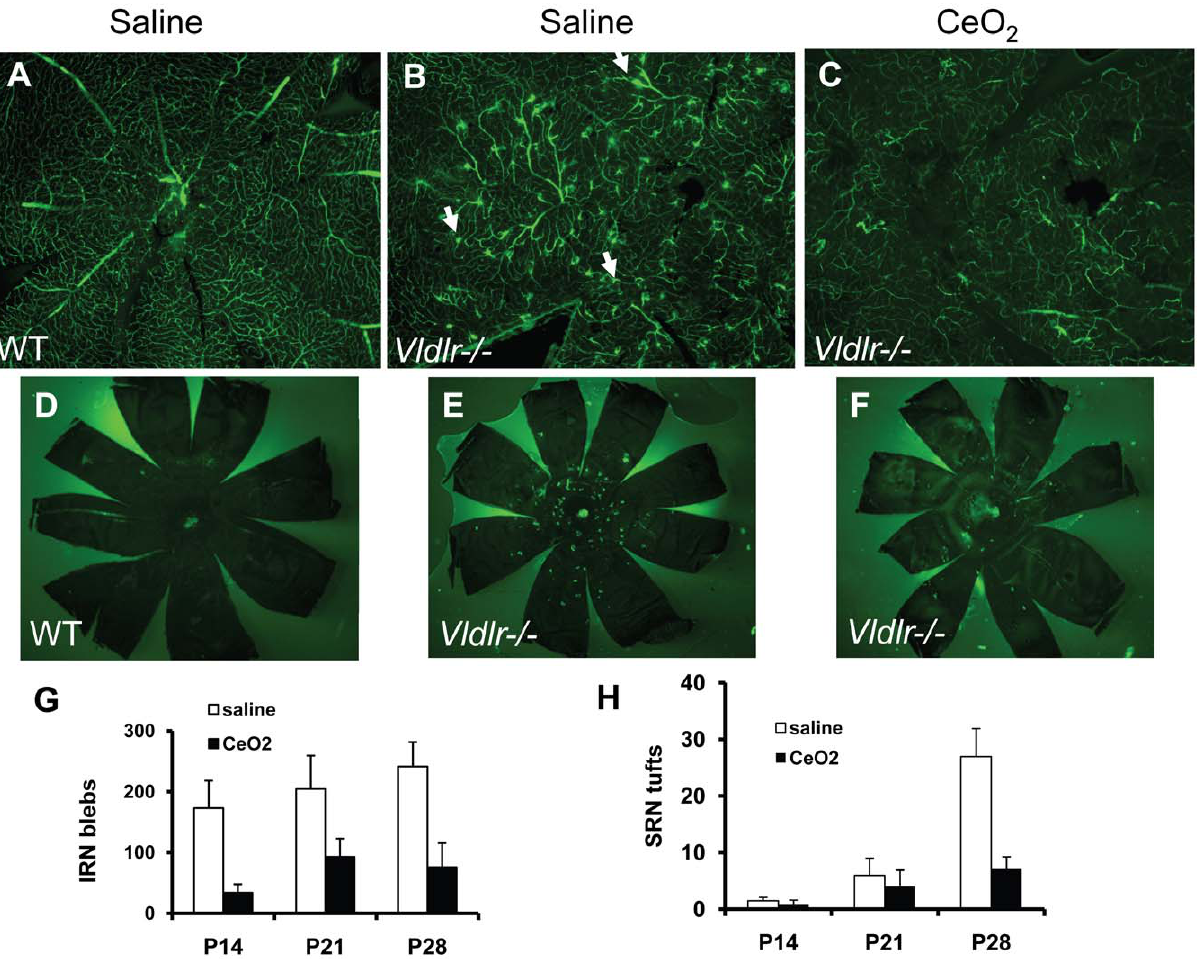
Figure 5. Nanoceria inhibit the development of pathologic intra-, and sub-retinal vascular lesions in the Vldlr-/- retina. Photomicrographs of whole mount retinas ( A–C ) and eyecups (RPE, choroid, and sclera) ( D–F ) from P28 animals are shown. All retinal blood vessels were labeled green by the vascular filling assay. WT retinas ( A ) showed the normal web-like retinal vasculature whereas those from the Vldlr-/- mice ( B ) showed numerous intraretinal vascular lesions or ‘‘blebs’’ (IRN blebs). See white arrows for examples. A single injection of nanoceria at P7 inhibited ( C ) the appearance of these lesions. Eyecups from WT mice ( D ) showed no SRN ‘‘tufts’’ but those from Vldlr-/- mice ( E ) had many bright SRN tufts. A single injection of nanoceria on P7 inhibited the appearance of these SRN tufts ( F ). G and H show the quantitative analyses of IRN blebs and SRN tufts from this set of the experiment. Data were from nine animals, three at each of the three developmental ages (P14, P21, P28) with or without nanoceria. * p , 0.05; **p , 0.01. See text for further information.